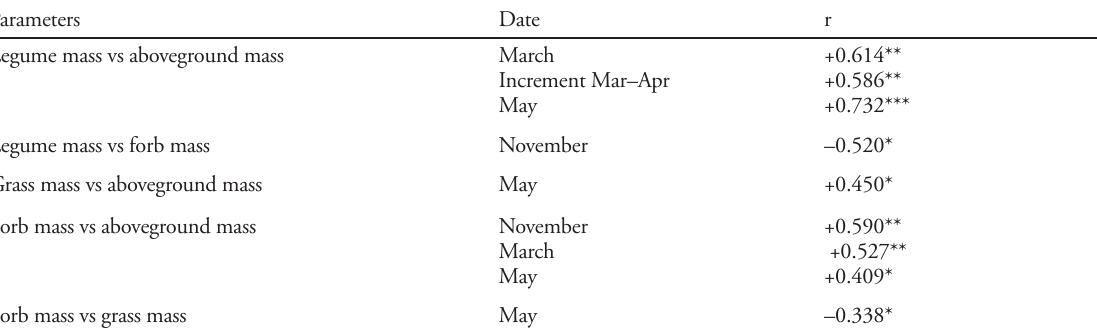
Table 4. Linear regression between components of the biomass. Spearman’s coefficients are reported. *p < 0.05, ** p < 0.01, ***p < 0.001.